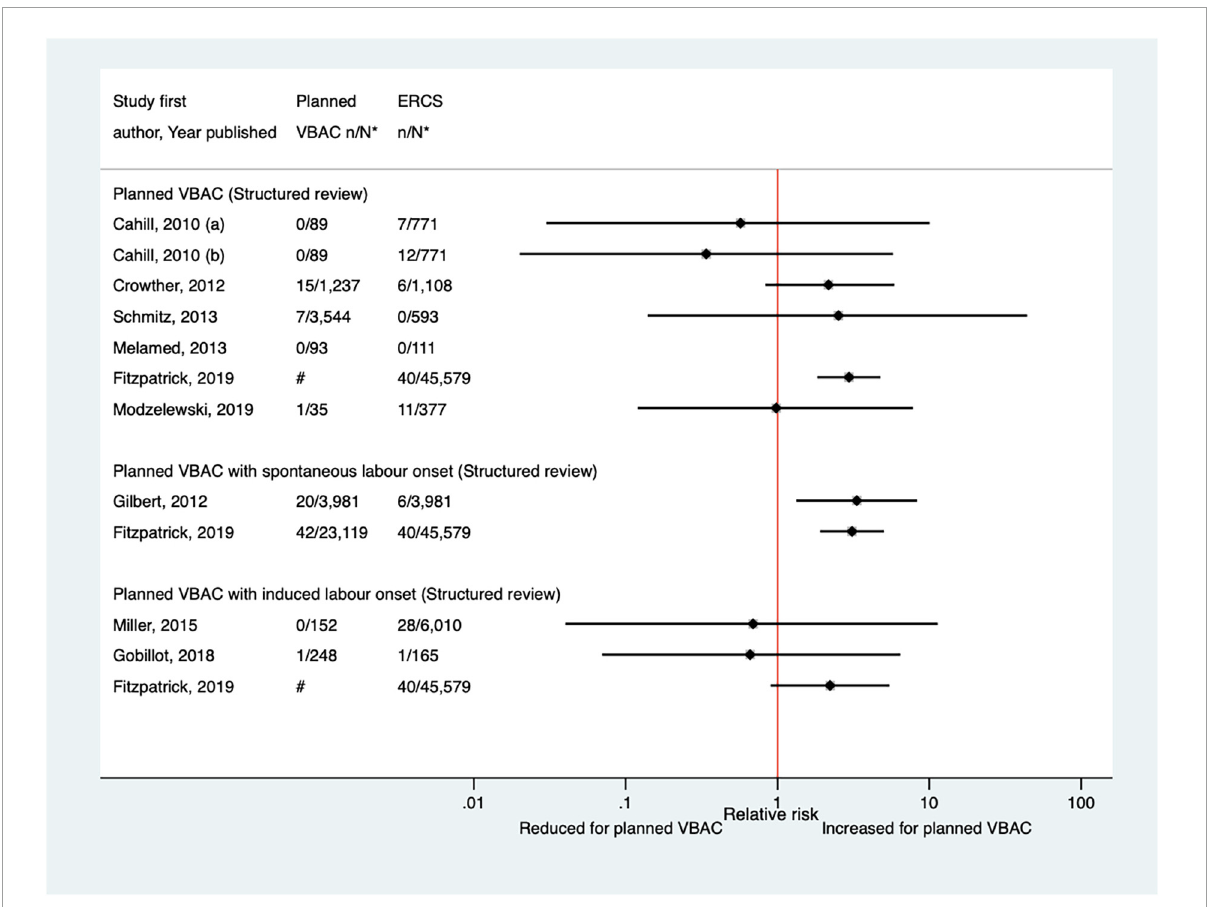
FIGURE6 Risk of maternal surgical injury for planned VBAC vs. ERCS. ∗ n , number in group with the outcome; N , Total number in group. Cahill et al. (35) (a) outcome: surgical injury, (b) outcome: bladder injury. # Numbers have not been shown to protect against potential disclosure risks. ERCS, elective repeat cesarean section; VBAC, vaginal birth after previous